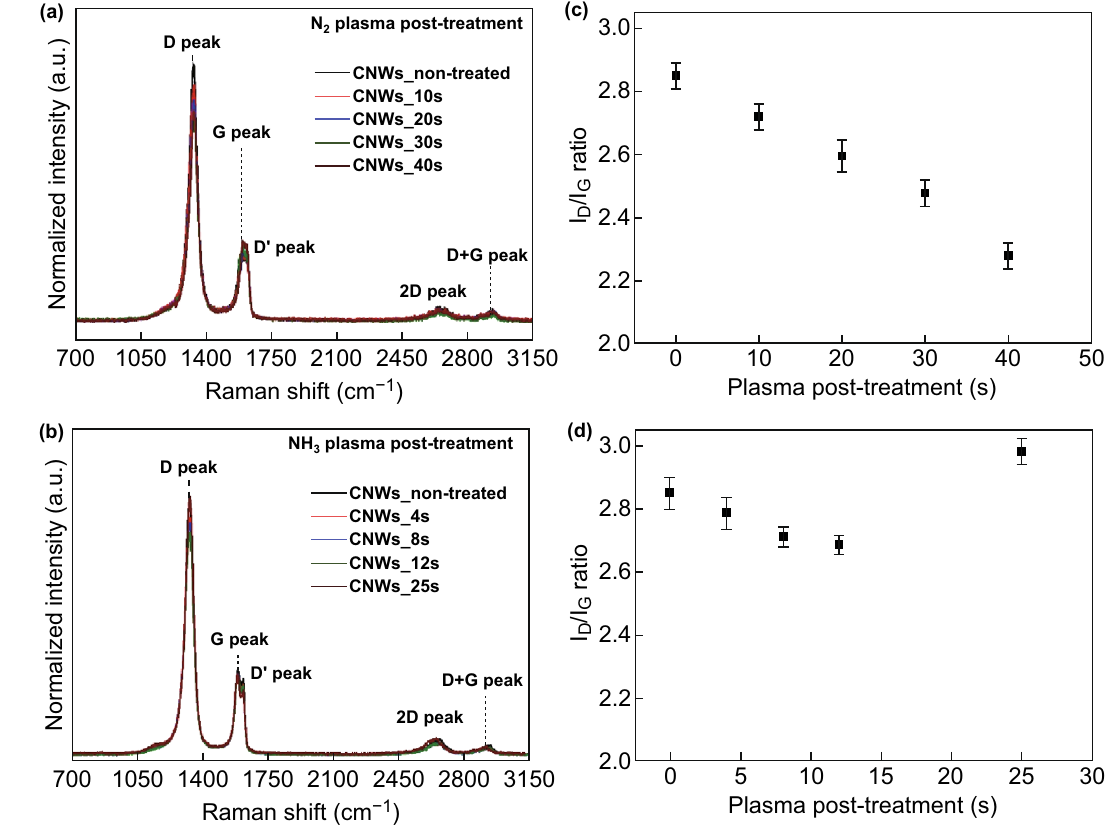
Fig. 3 a , b Raman spectra of CNWs before and after N 2 and NH 3 plasma post-treatments. c , d I D / I G ratio of CNWs before and after N 2 and NH 3 plasma